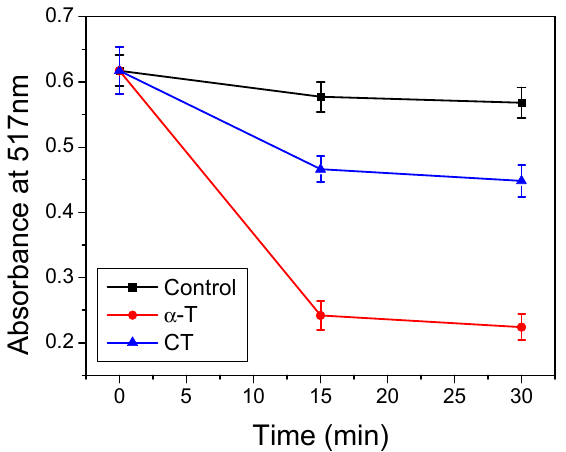
Figure 6. Absorbance at 517 nm of DPPH radicals in methanol in the presence of CT or α -T after 15 and 30 min of incubation. Indicated values represent the means ± SD arising from triplicate experi- ments.